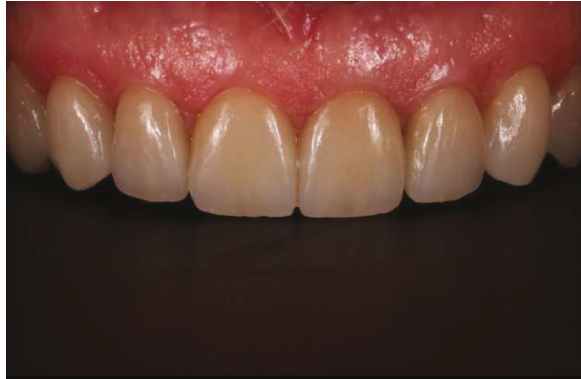
Figure 12: Final intraoral maxillary frontal